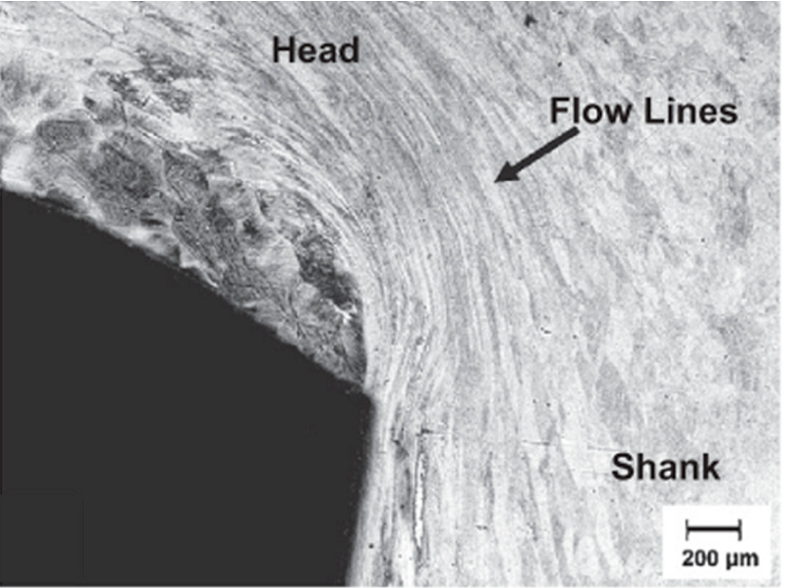
Figure 13. Optical micrograph showing material flow at the junction of head and shank in the bolts [95].